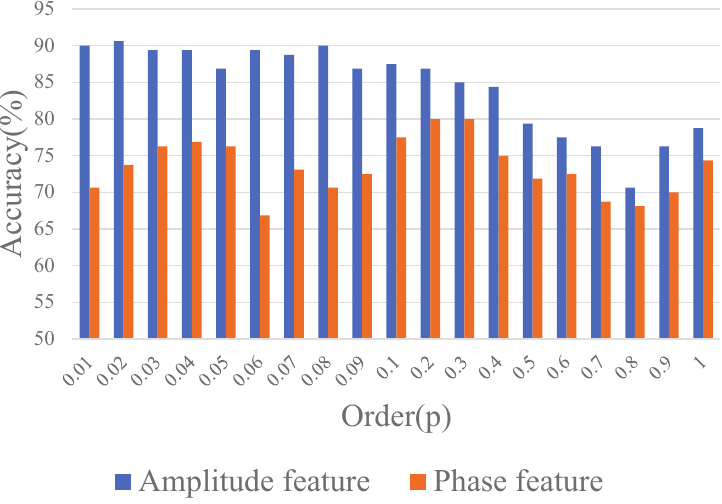
Figure 10. Classification results of Amplitude and Phase features under different orders using the original BCCT200